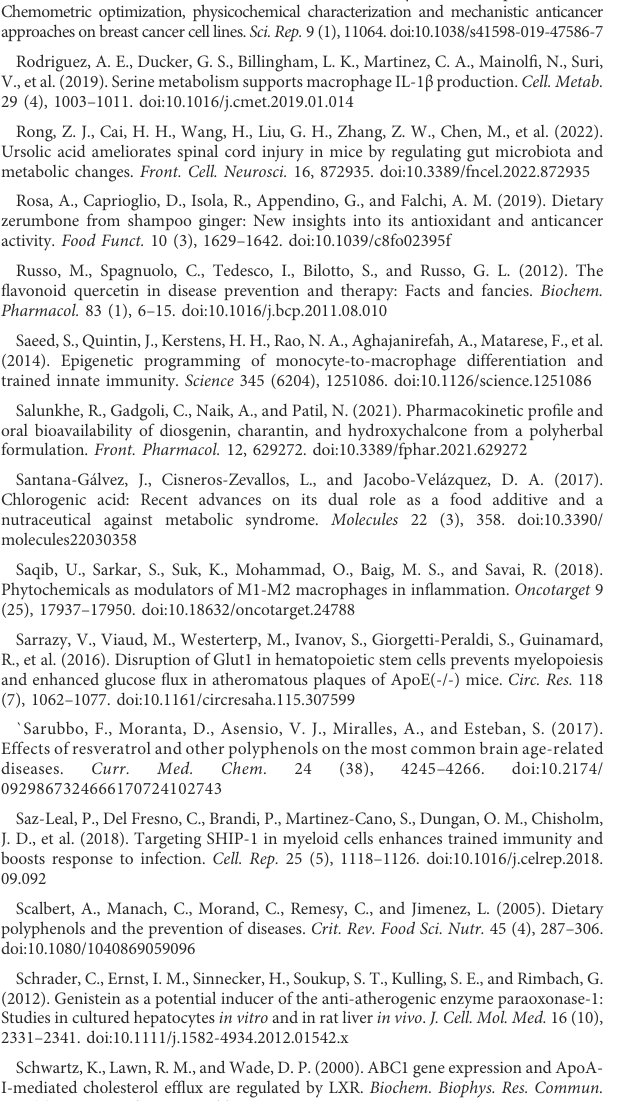
Tabas, I., and Bornfeldt, K. E. (2020). Intracellular and intercellular aspects of macrophage immunometabolism in atherosclerosis. Circ. Res. 126 (9), 1209 –